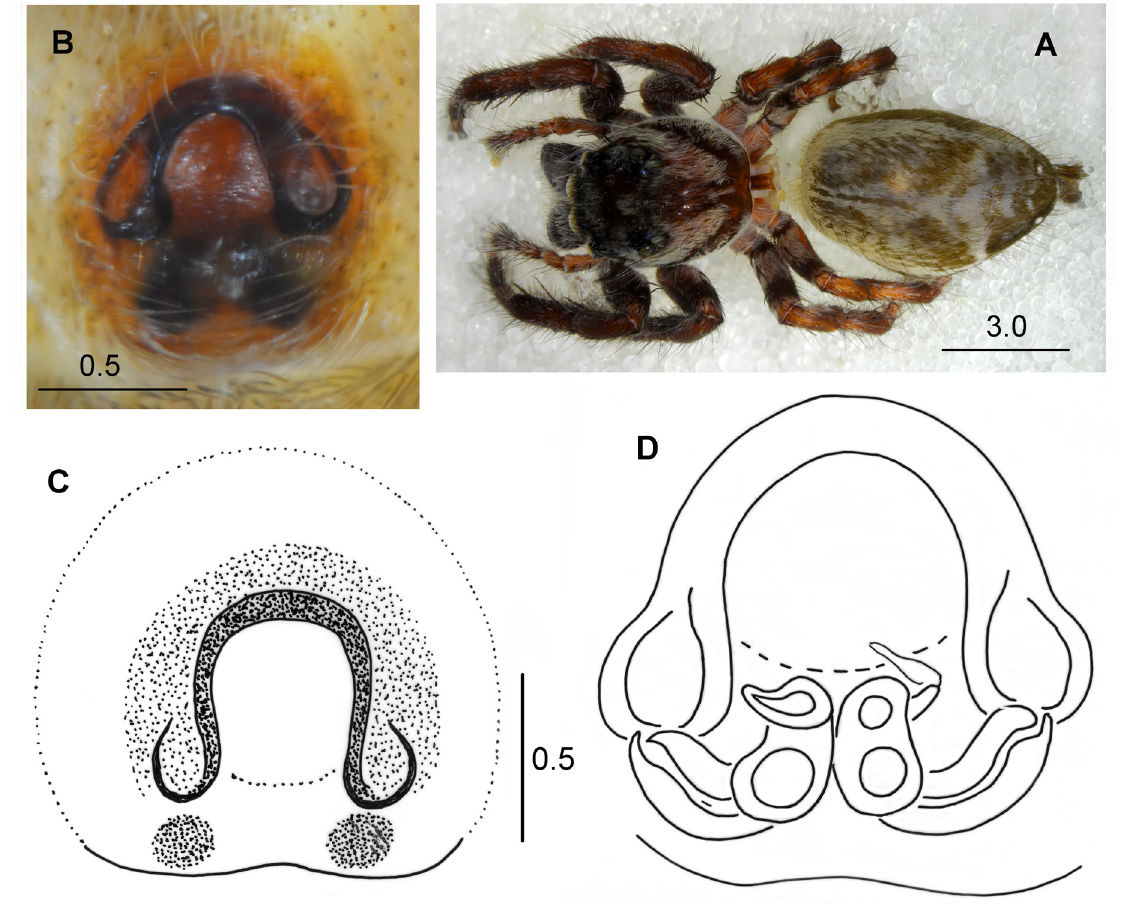
Fig. 20. Hyllus leucomelas (Lucas, 1858), ♀ (MNHN). A . Habitus. B–C . Epigyne. D . Internal structure of